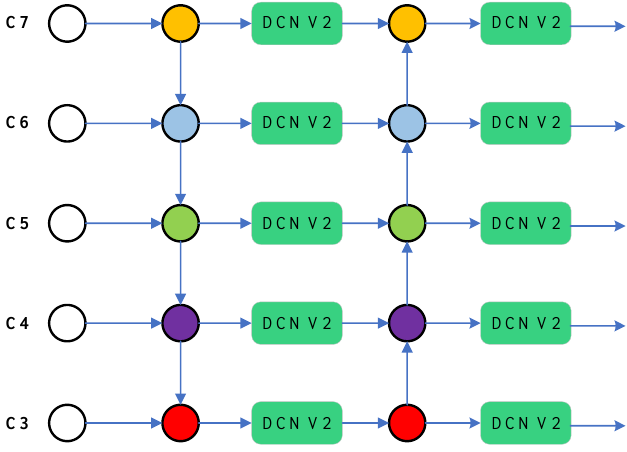
Figure 4. The enhanced feature